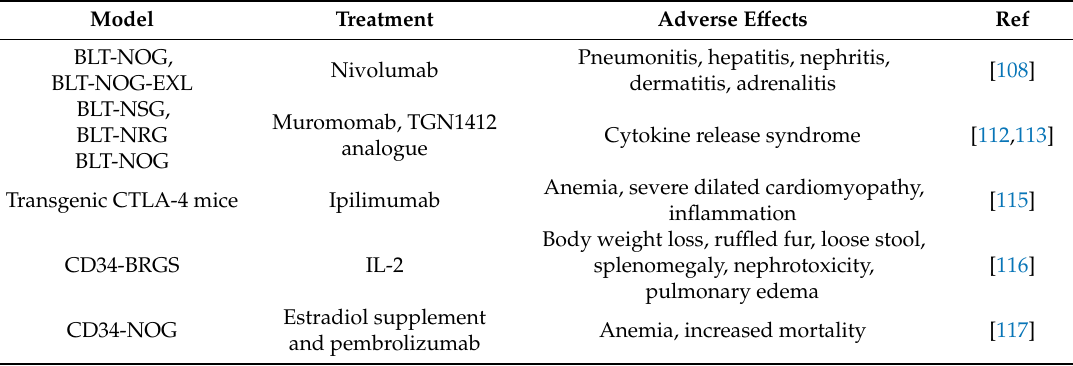
Table 2. Summary of treatment-induced adverse e ff ects in humanized mouse